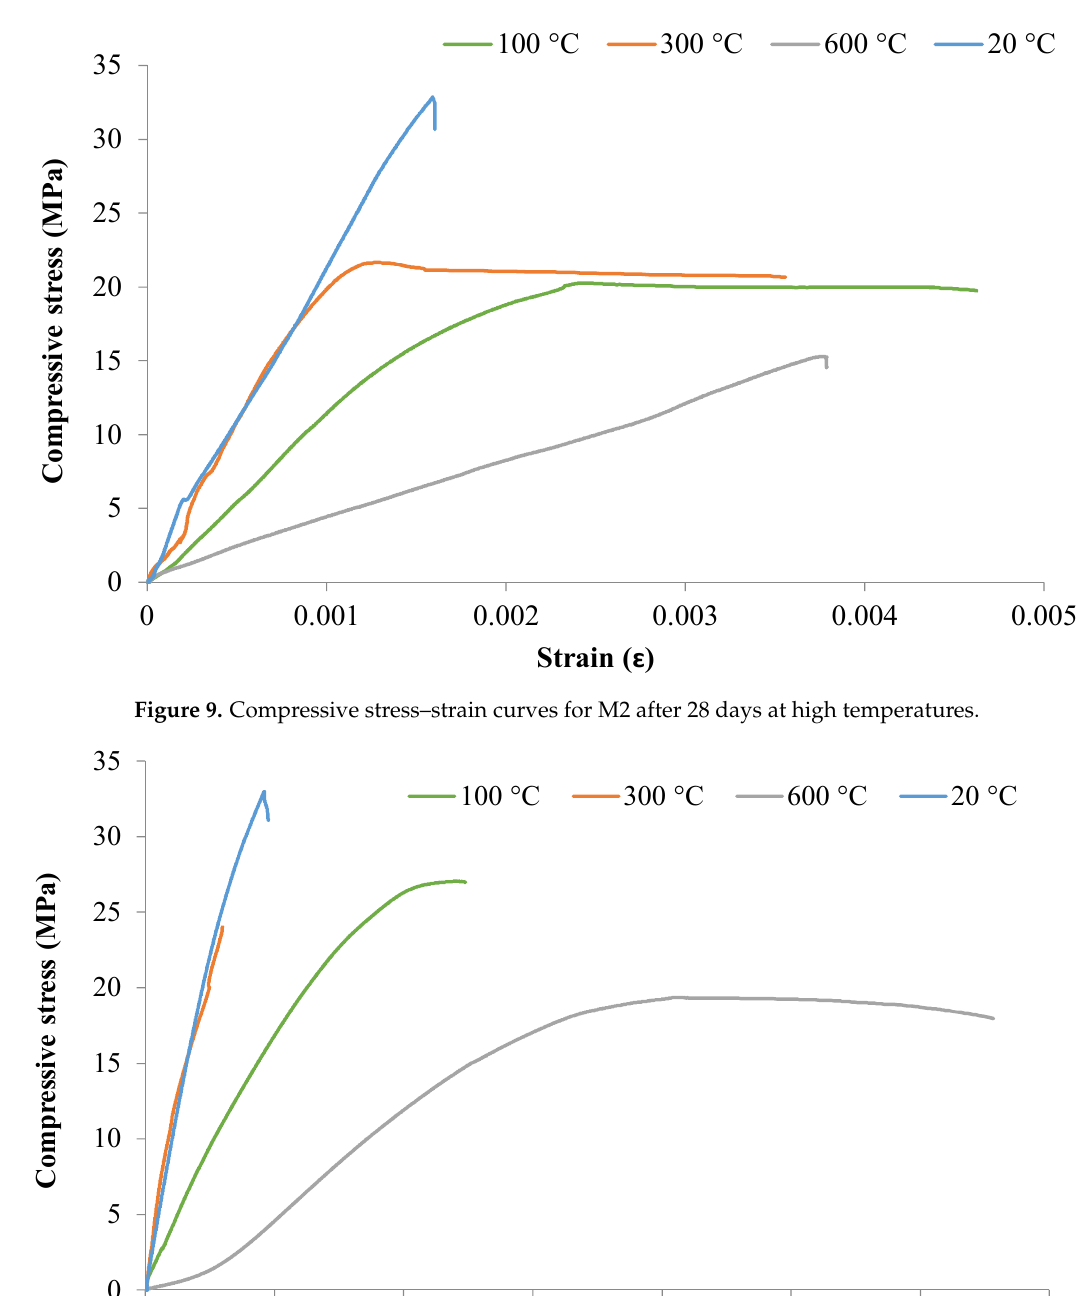
Figure 8. Flexural strength versus days at 20 °C.